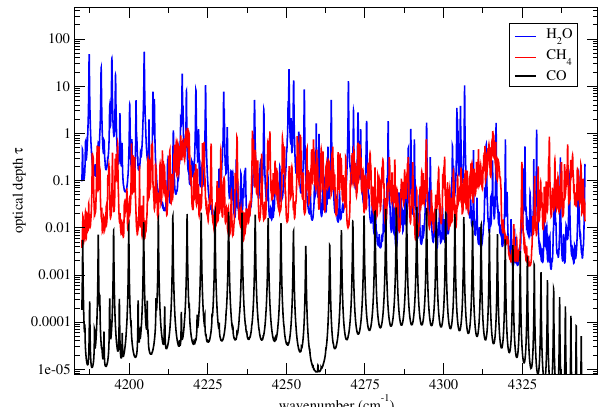
Fig. 2. Approximate optical depth versus wave numbers, attributed to the three species considered for the spectral range 4190–4340 cm − 1 : CH 4 (red), H 2 O (blue), and CO